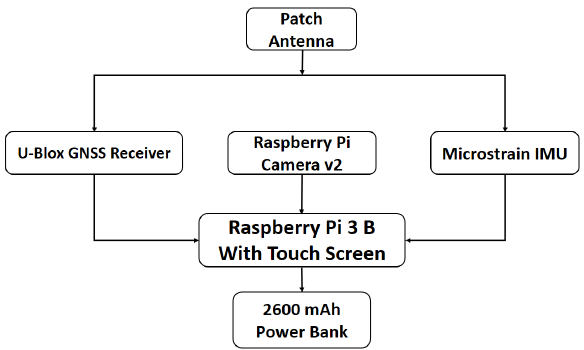
Figure 7. Architecture of photogrammetry system installed on UAV The Raspberry Pi camera is set to 2 frames per second with 2592*1944 resolution and images are saved with a GPS timestamp automatically. The Raspberry Pi camera is connected to the Raspberry Pi system through a camera serial